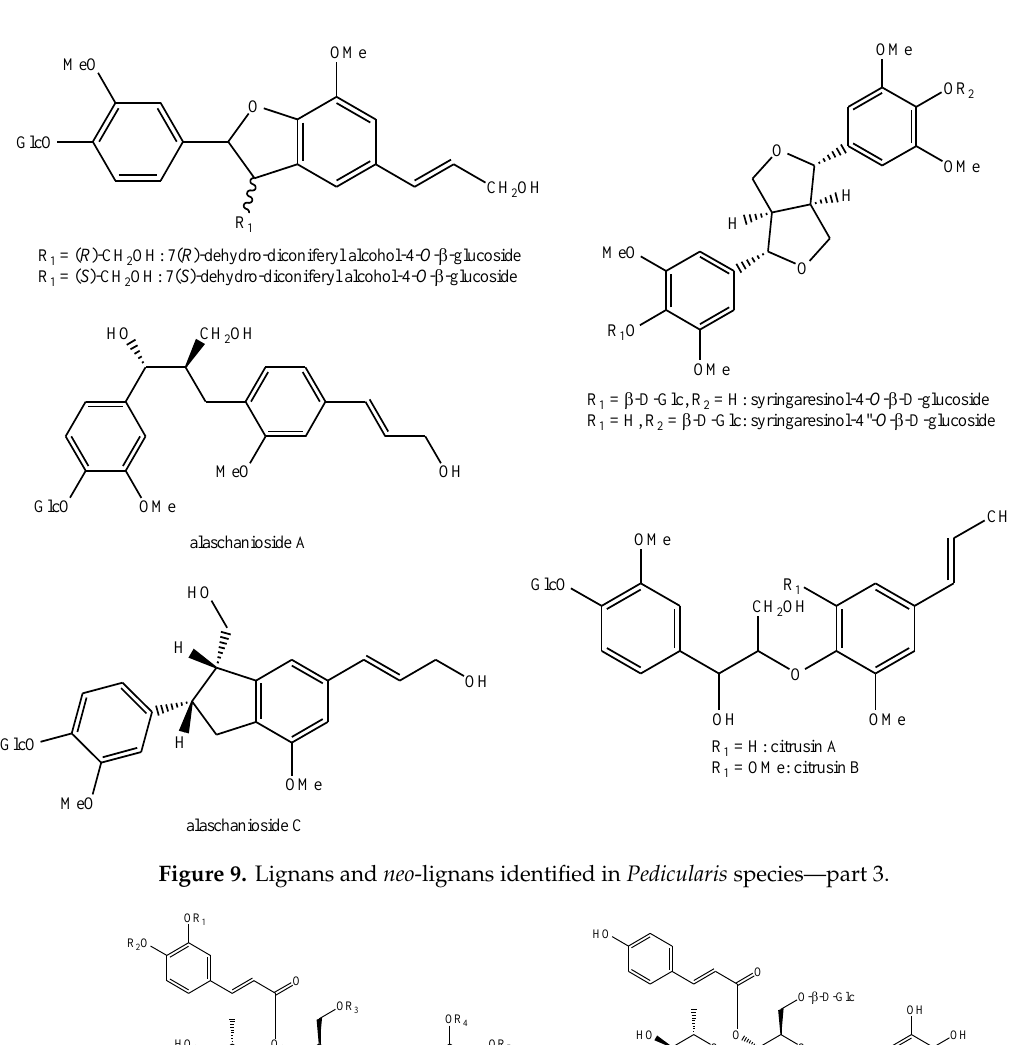
Figure 8. Lignans and neo -lignans identified in Pedicularis species—part 2.